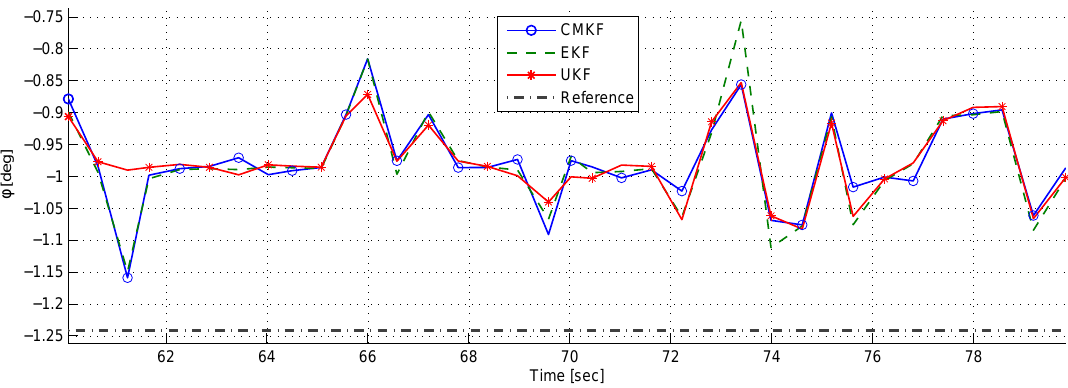
Figure 14. A comparison of the azimuth estimation using different filters in the static experiment.